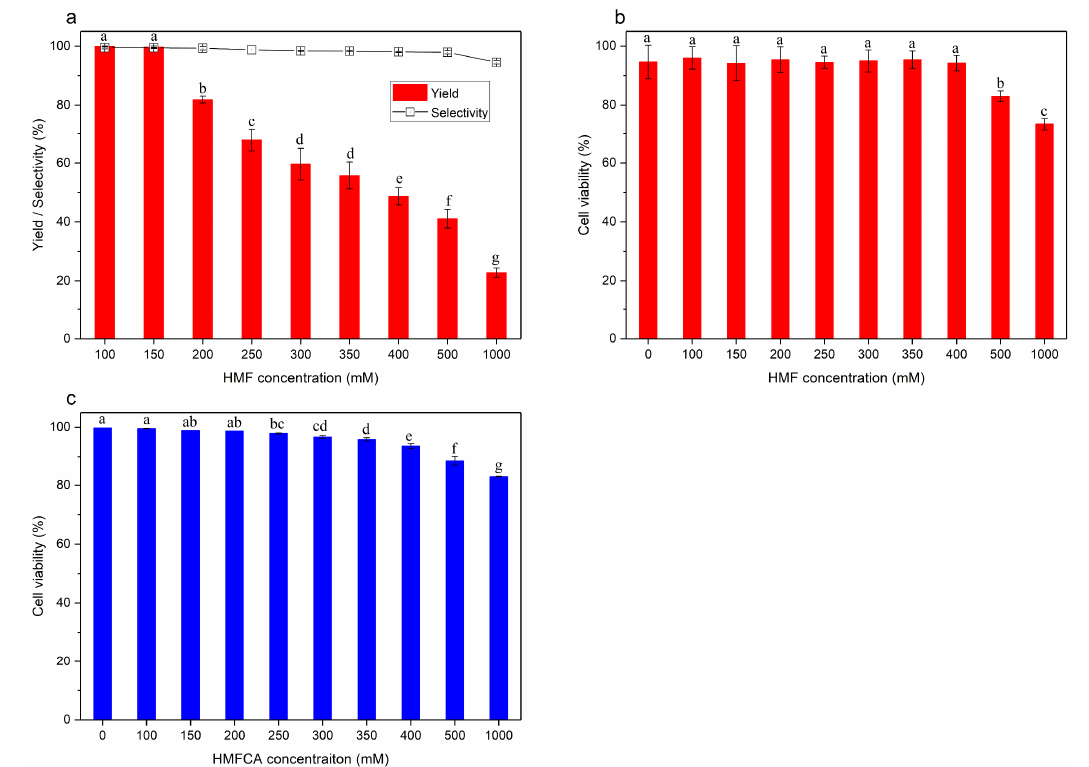
Figure 2. E ff ects of HMF concentration on ( a ) HMFCA synthesis and ( b ) cell viability. Reaction conditions: 0.12 g / mL microbial cells, in phosphate bu ff er (100 mM,pH 7.0) under 850 rpm and 35 ◦ C. Fresh harvested cells incubated without HMF / HMFCA under identical conditions were used as a control. Reaction periods: 12 h for 100 mM 150 mM; 24 h for 200 mM, 250 mM; and 36 h for 300 mM, 350 m, 400 mM, 500 mM, 1000 mM. ( c ) E ff ects of the product concentration on cell viability. HMFCA was incubated for 24 h under the same